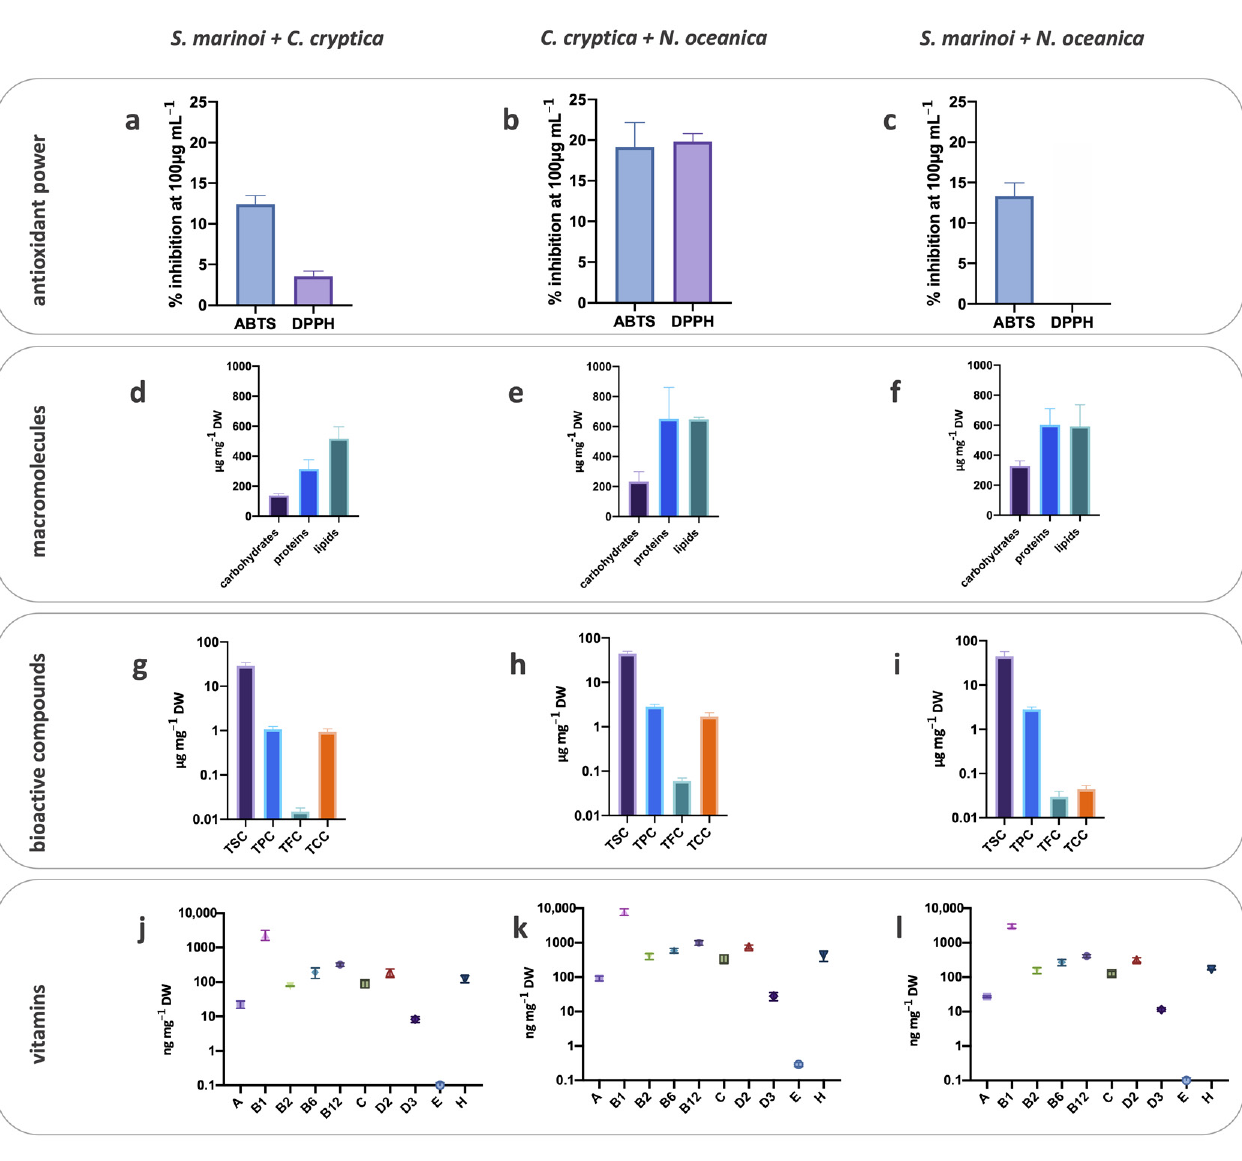
Figure 2. Antioxidant capacity (ABTS and DPPH scavenging ability) of the biomass from S.m. + C.c. ( a ), C.c. + N.o. ( b ) and S.m. + N.o. ( c ); macromolecular composition of the biomass from S.m. + C.c. ( d ), C.c. + N.o. ( e ) and S.m. + N.o. ( f ); bioactive compounds content of the biomass from S.m. + C.c. ( g ), C.c. + N.o. ( h ) and S.m. + N.o. ( i ) and vitamin content of the biomass from S.m. + C.c. ( j ), C.c. + N.o. ( k ) and S.m. + N.o. ( l ) (y axis in log scale). S.m. = Skeletonema marinoi , C.c. = Cyclotella cryptica , N.o. = Nannochloropsis oceanica . TSC = total sterols content, TCC= total carotenoids content, TPC = total polyphenols content, TFC= total flavonoids content. Values are expressed as mean ± SD.